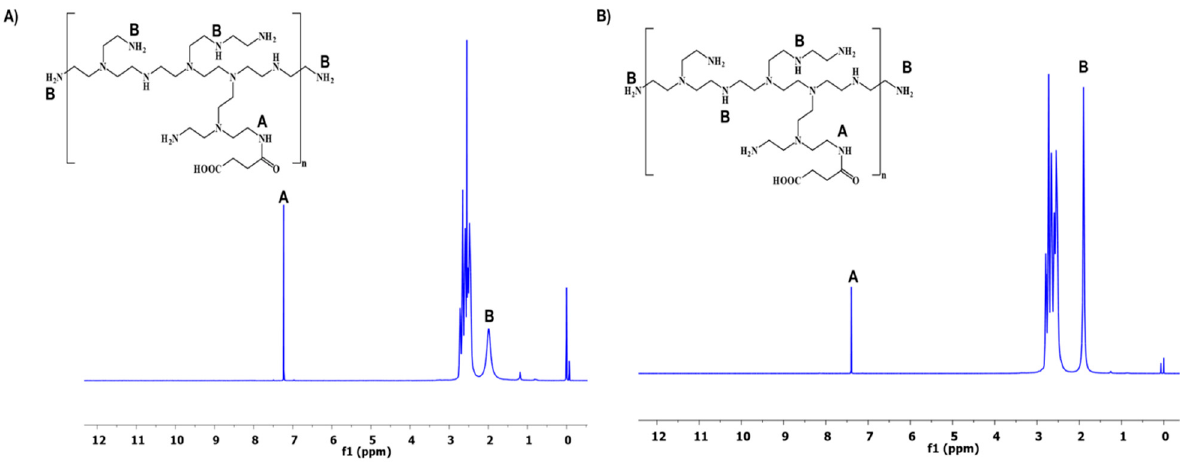
Figure 2. 1 H NMR spectra of the intermediate PEI–SA: PEI-10 kDa ( A ) and PEI-25 kDa ( B ).